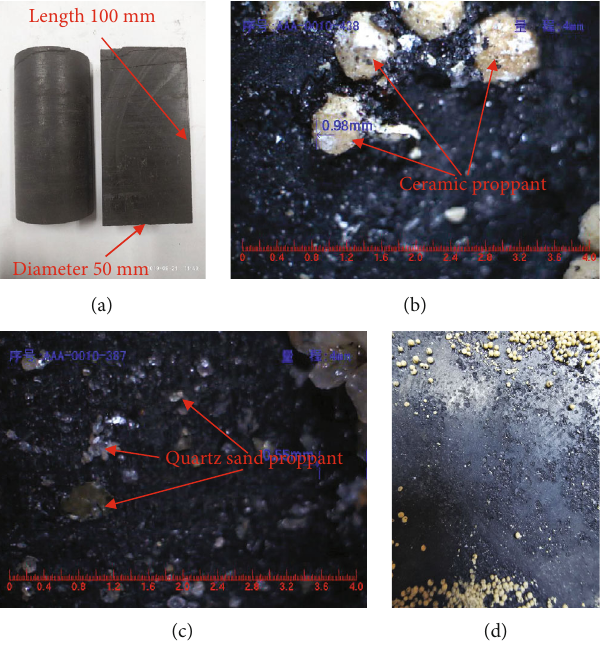
Figure 10: Photograph of the proppant embedment phenomenon. (a) The surface of the coal sample before the experiment. (b) The embedment of the ceramic proppant. (c) The embedment of the quartz sand proppant. (d) The embedment of the coal sample surface after the